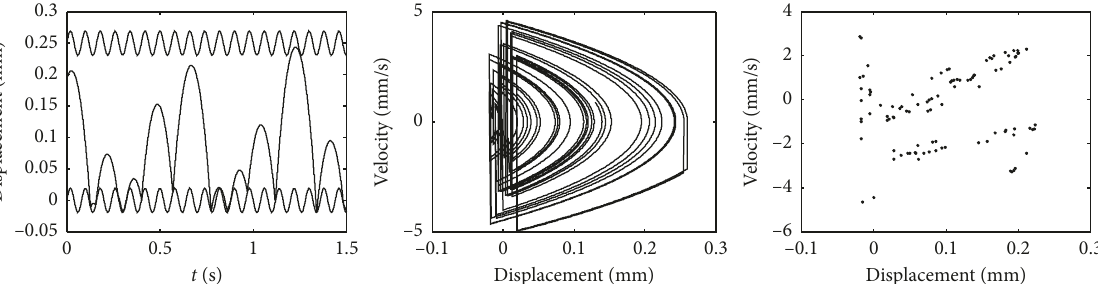
Figure 14: Nonlinear dynamic responses of gear impact. (a) Equivalent displacement diagram. (b) Phase map. (c) Poincar´e map.